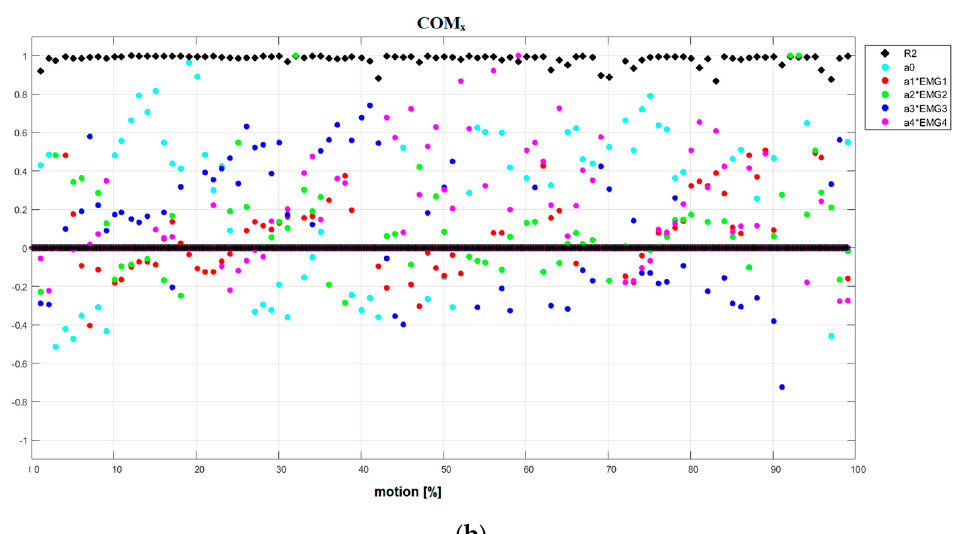
Figure 5. ( a ) Results of linear piecewise multi-regression analysis performed in each tested fragment of the motion for reference subject in Motion1 under natural conditions. COM x . ( b ) Results of linear piecewise multi-regression analysis performed in each tested fragment of the motion for DMD patient in motion1 under natural conditions. COMx.